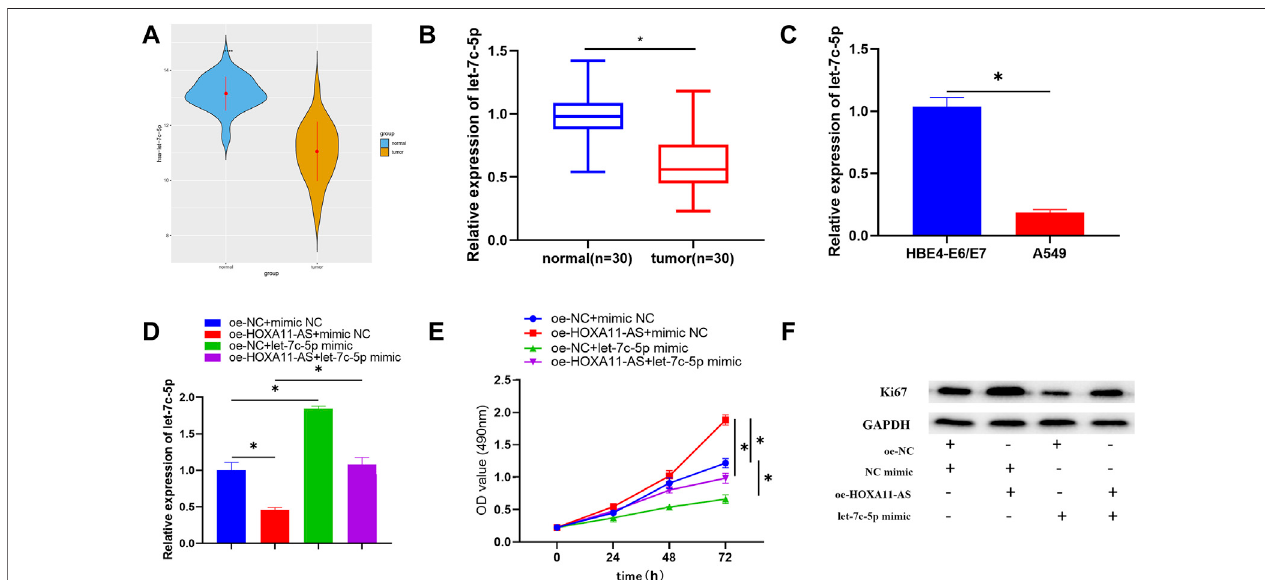
FIGURE 3 | Let-7c-5p is poorly expressed in LUAD cells, hinders LUAD cell proliferation, and can alleviate the capacity of HOXA11-AS on proliferating the LUAD cells. (A,B) Let-7c-5p expression in LUAD tissue and adjacent normal tissue. (C) Expression of let-7c-5p in normal cell line HBE4-E6/E7 and LUAD cell lines A549 evaluatedinqRT-PCRassay. (D) let-7c-5pexpression ineachtransfection groupmeasured byperformingqRT-PCR. (E) CCK-8wasapplied totest theviabilityofcells. (F) Ki67 expression was measured by Western blot; * p <